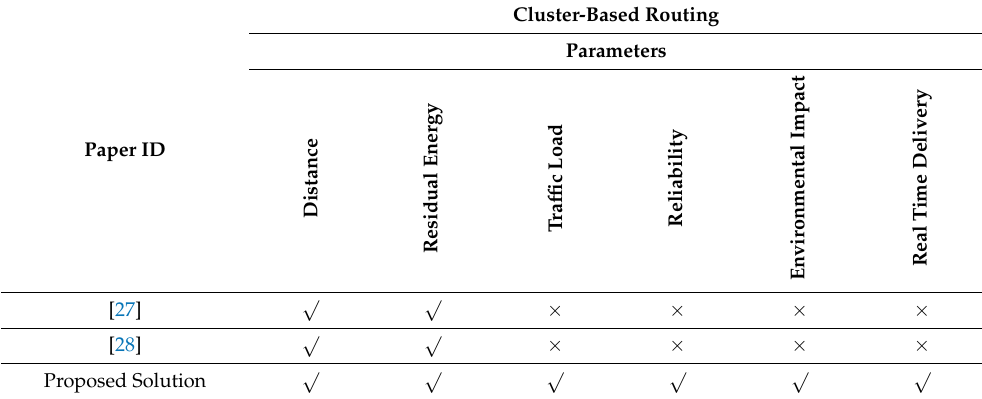
Table 2. A comparative summary of the two algorithms mentioned earlier [27,28] and the proposed